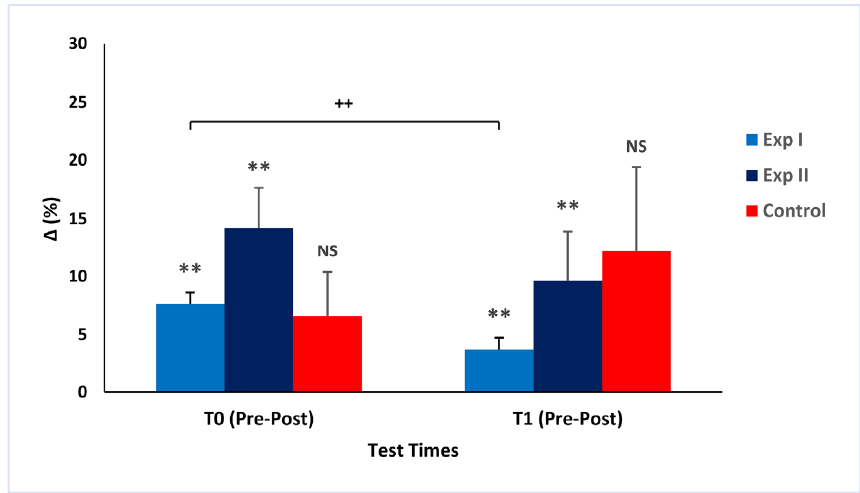
Figure 3. Mean values and standard deviations are shown. Acute relative changes in flexibility in the testing sessions T0 (baseline) and T1 (after 12 weeks). ** Significant changes within the group ( p < 0.05); ++ significant changes between two groups ( p < 0.01); NS—no significant changes ( p > 0.05).